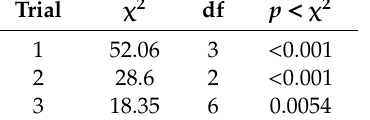
Table A1. Statistical results for male Trissolcus japonicus in trials 1–3 testing survival. Treatment differences were assessed using log-rank analysis.